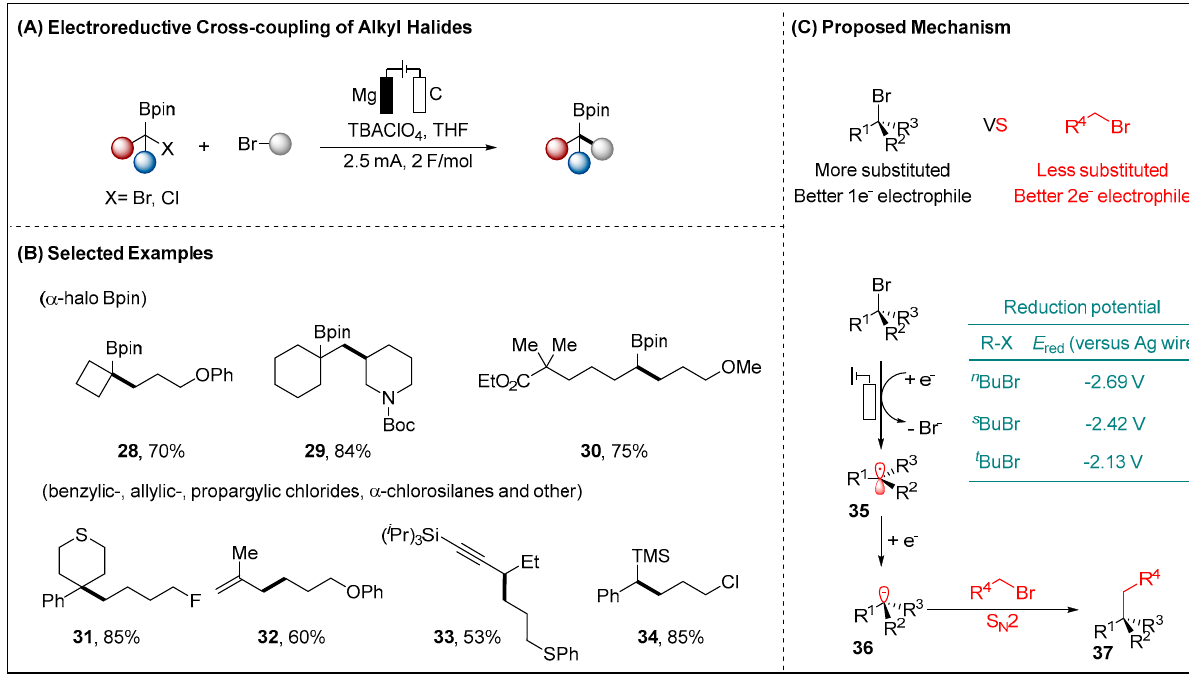
Figure 6. Electrochemically driven cross-electrophile coupling of alkyl halides.